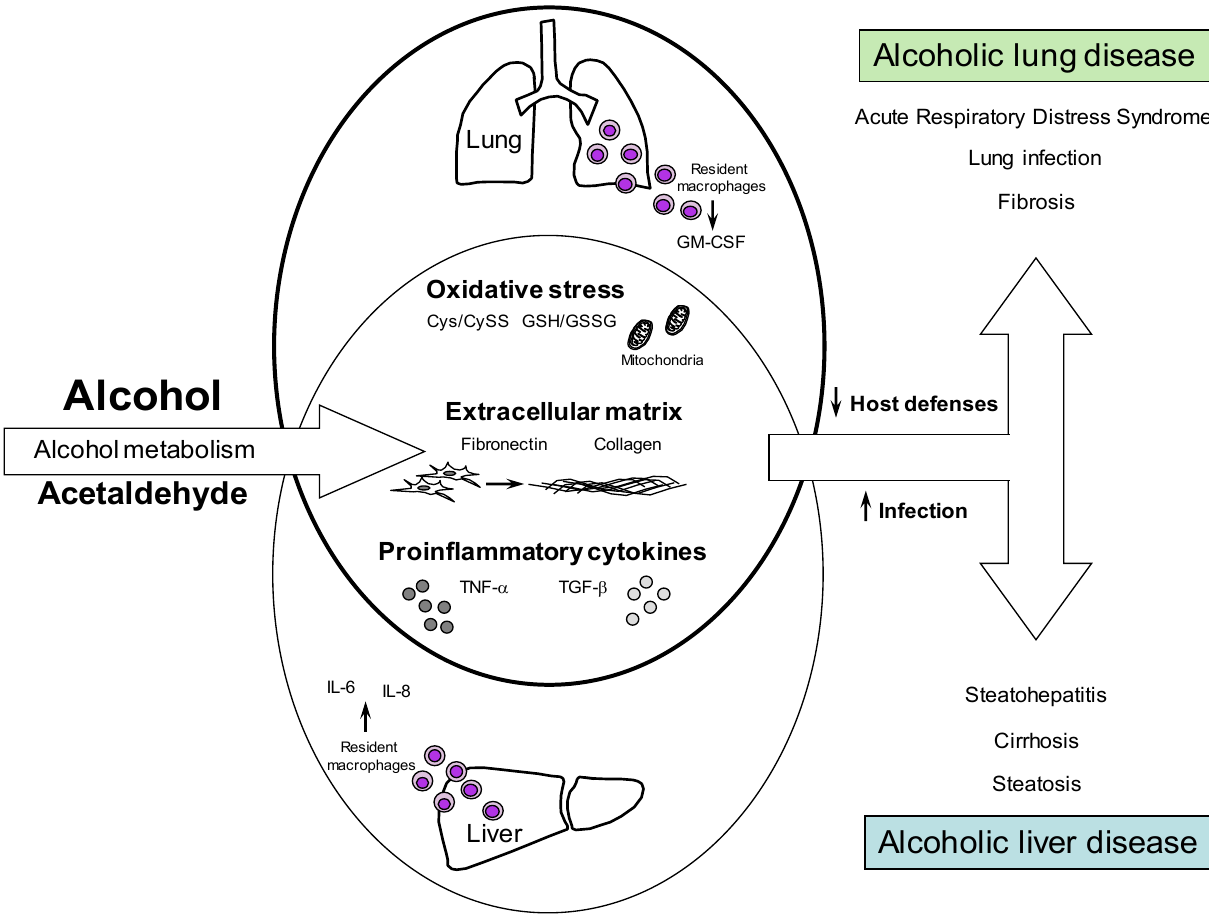
Figure 1. Effect of alcohol on the gut/liver/lung axis. Alcohol induces tissue damage in liver and lung through shared mechanisms of action that promote the progression of alcoholic liver and lung disease. Resident macrophages found in both the liver and lung play key roles in mediating inflammatory responses including the induction of cytokines such as IL6, IL-8, TNF-α, TGF-β, and GM-CSF. Activation of tissue remodeling, with enhanced deposition of extracellular matrix components like fibronectin and collagen, and increased oxidative stress also contribute to tissue injury and organ dysfunction. Ultimately, alcohol-induced damage to both organs results in the impairment of host defense mechanisms and susceptibility to infection, tissue injury and